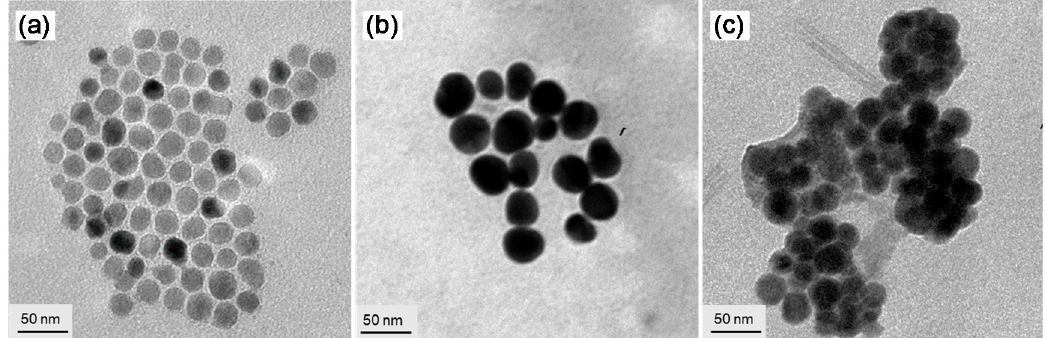
Figure 3. TEM micrograph images of ( a ) γ ‐ FeO x NPs, ( b ) γ ‐ FeO x @AuNP ( 4 ‐ NPs), and ( c ) ( γ ‐ FeO x @AuNP)@{ cis ‐ cup ‐ tris[C 60 (>DPAF ‐ C 9 )]} n ( 5 ‐ NPs), showing evolution of particle morphology changes and the soft organic material encapsulation on dark nanoparticles on the latter micrograph.